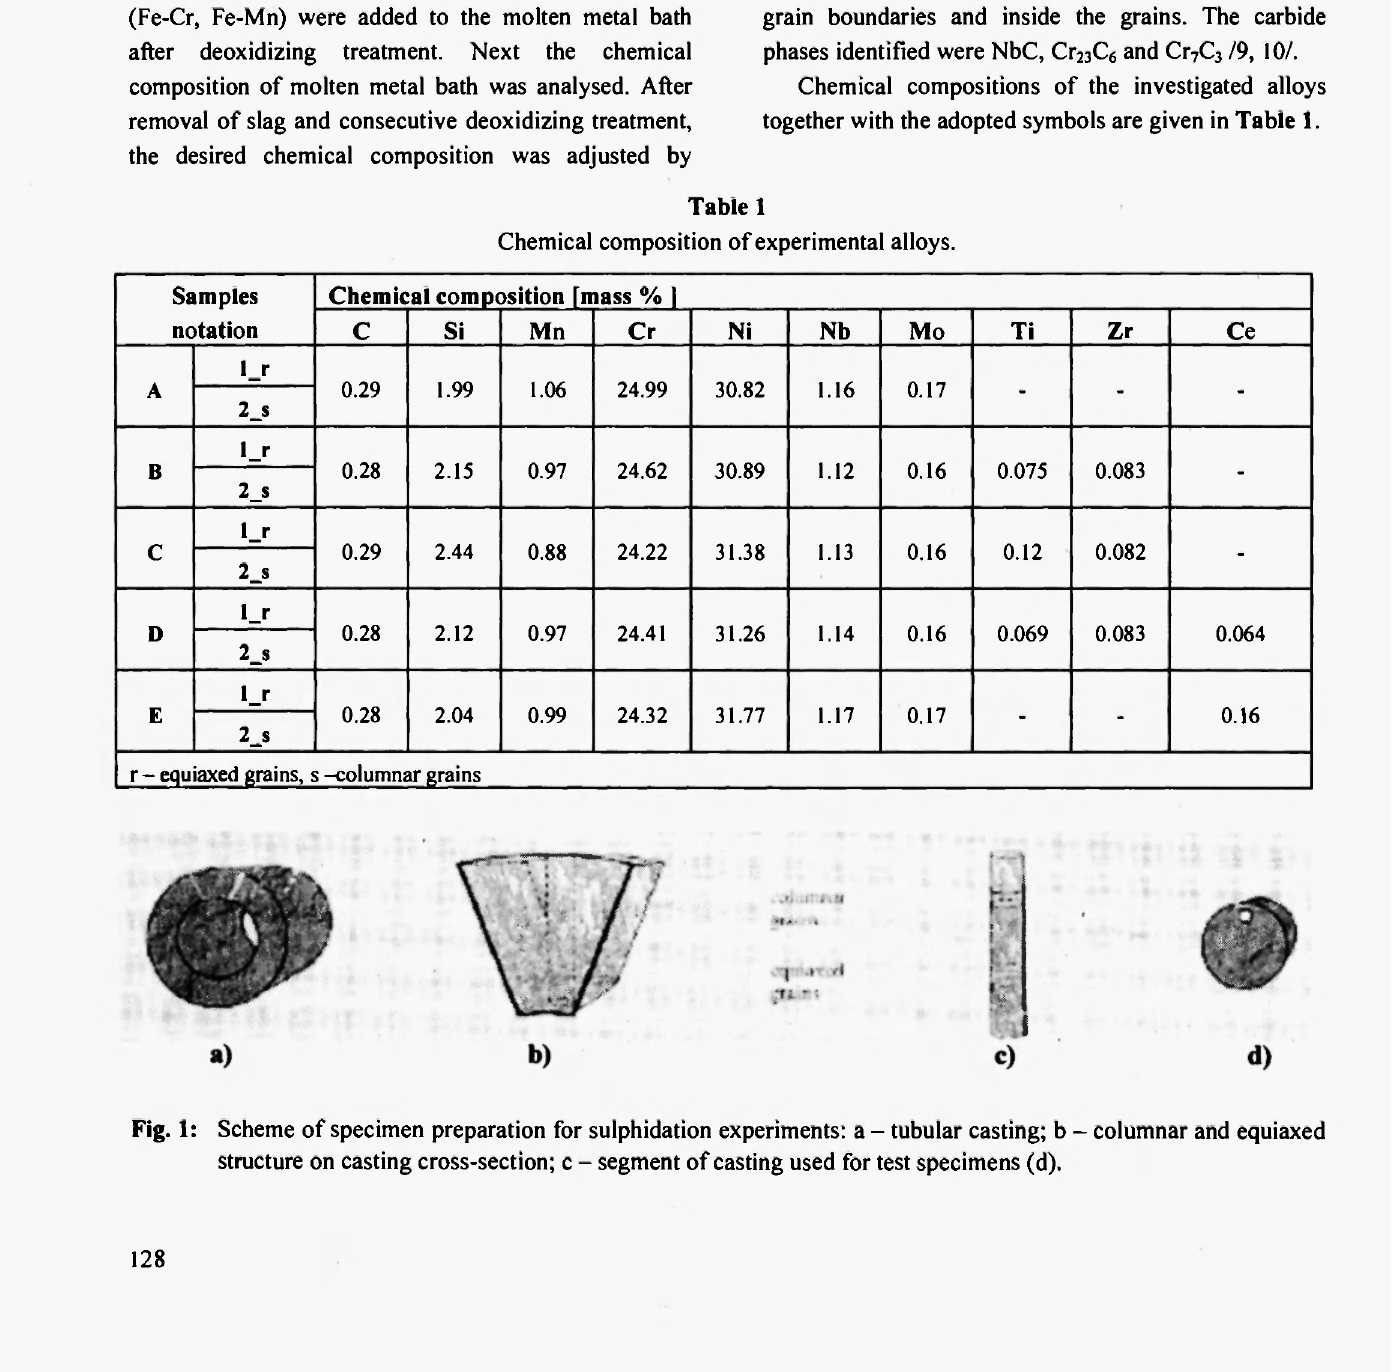
Fig. 1: Scheme of specimen preparation for sulphidation experiments: a - tubular casting; b - columnar and equiaxed structure on casting cross-section; c - segment of casting used for test specimens